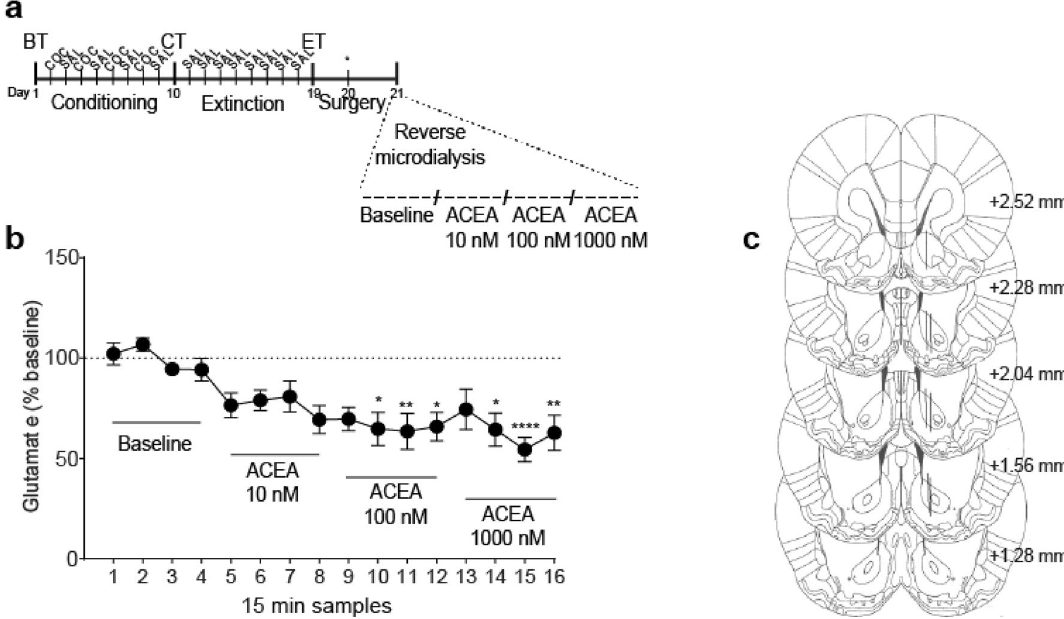
Figure 7. Effect of the CB1R agonist ACEA on basal extracellular glutamate levels in NAcore. ( a ) Timeline for CPP procedure. Animals that reached the extinction criteria were selected to receive increasing and consecutive doses of ACEA by reverse microdialysis [0, 10, 100 and 1000 mM]. Following the baseline, four samples for each concentration were collected. ( b ) Intra-NAcore local perfusion of ACEA significantly decreased extracellular glutamate in a concentration-dependent manner (*p < 0.05, **p < 0.01 and ****p < 0.0001 compared with baseline, using Bonferroni’s multiple comparisons post-hoc test, n = 7). Glutamate was quantified using EZChrom Elite software, version 4.0 (http:// www. agile nt. com). ( c ) Locations of microdialysis membranes (solid lines) in NAcore for subjects that were included in the present analysis. Numbers to the right indicate millimeters from the